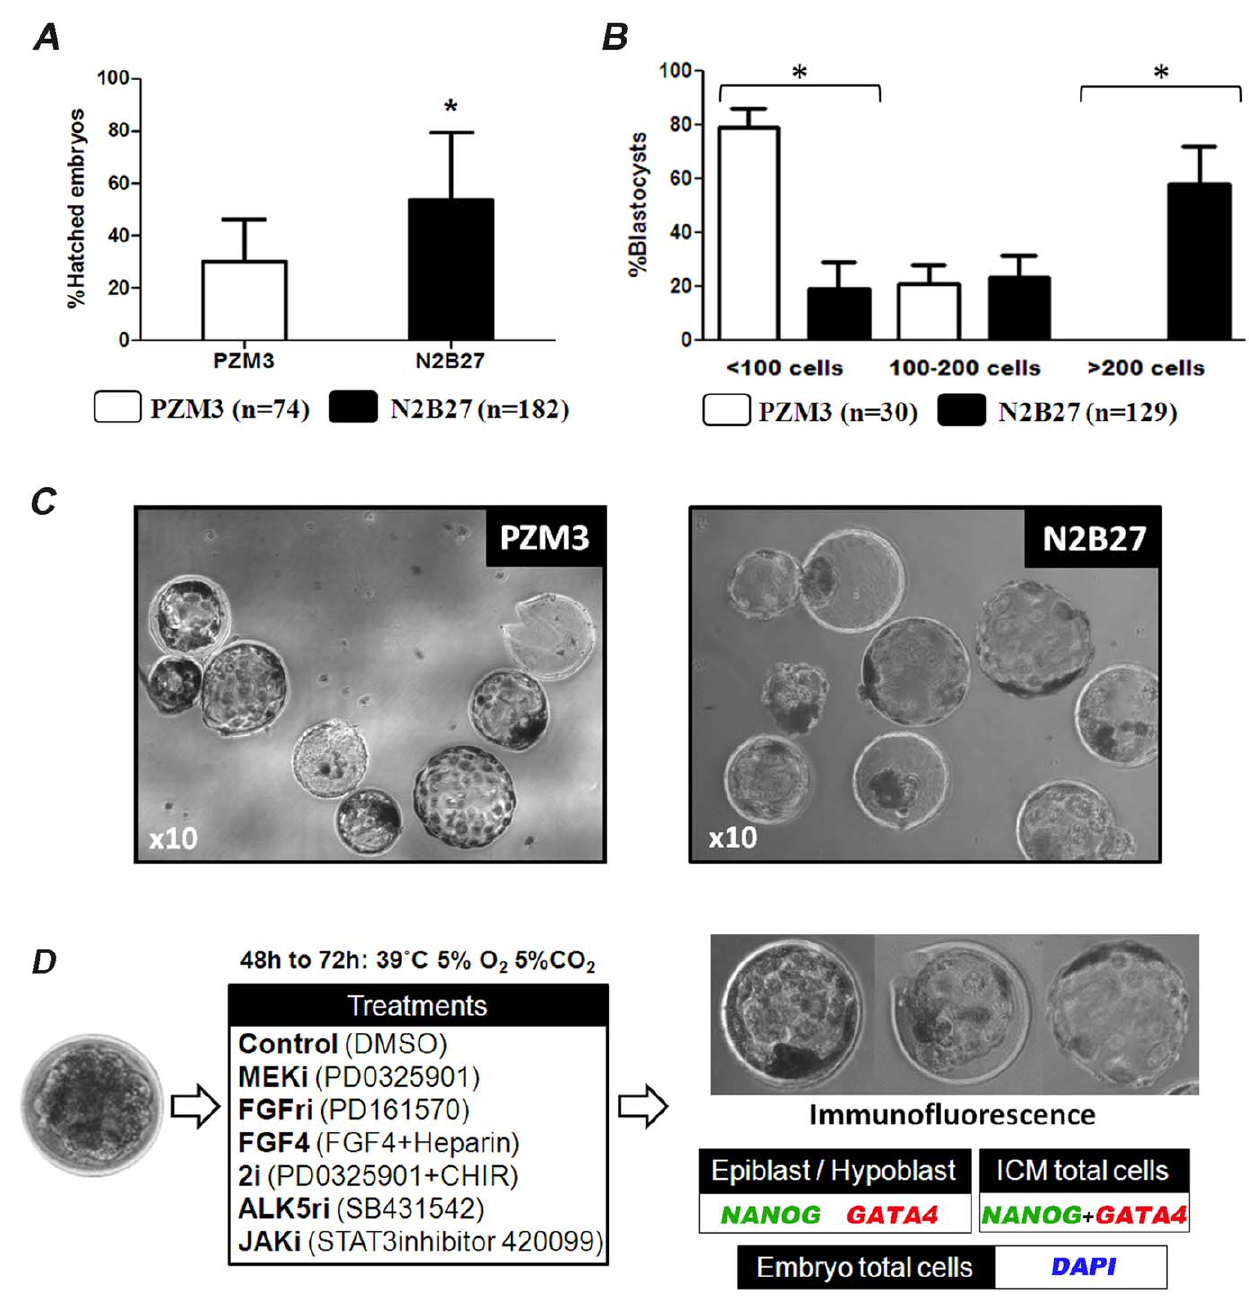
Figure 1. Development of pig morulae after in vitro culture. A) Proportion of embryos hatching from the zona pellucida after culture in PZM3 and N2B27. B) Cell count of blastocysts developing after culture in PZM3 and N2B27. C) Images of embryos obtained after incubation of morulae in PZM3 and N2B27. D) Diagram depicting the experimental design used to study signalling pathways involved in the segregation of ICM. * P , 0.05.